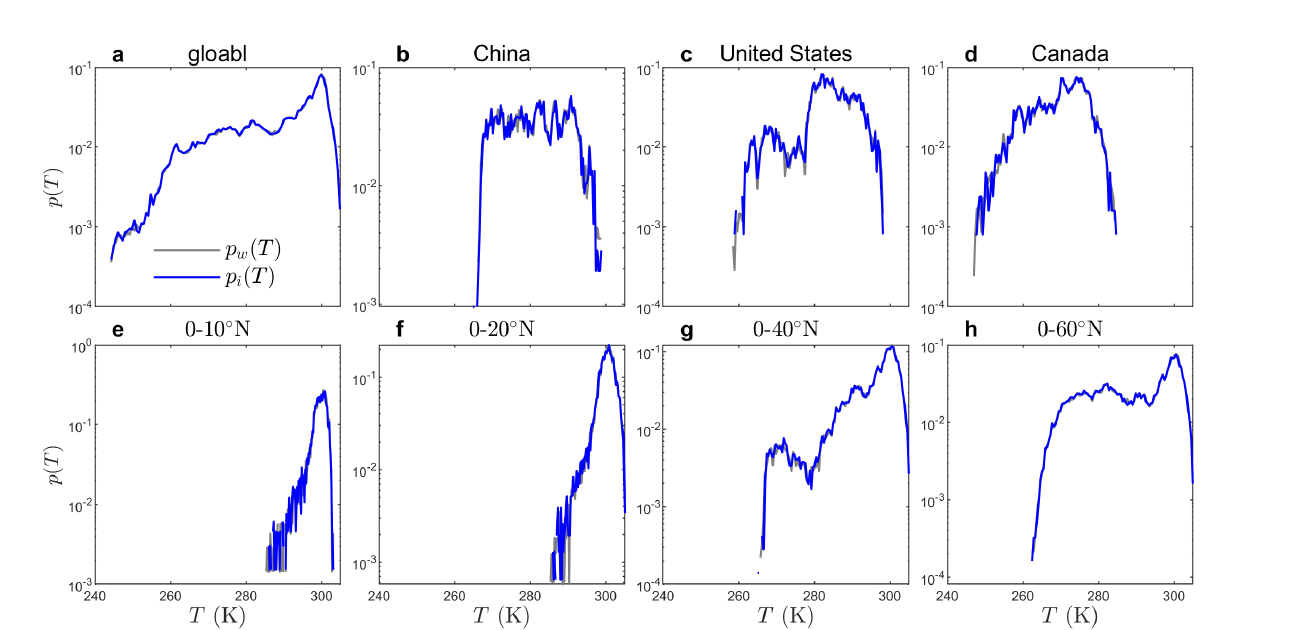
Figure 8. Comparison of the temperature distributions from weighted and interpolated samples in 2021 ( a ) over the globe, across ( b ) China, ( c ) the United States, and ( d ) Canada ( e ) 0–10 ◦ N,